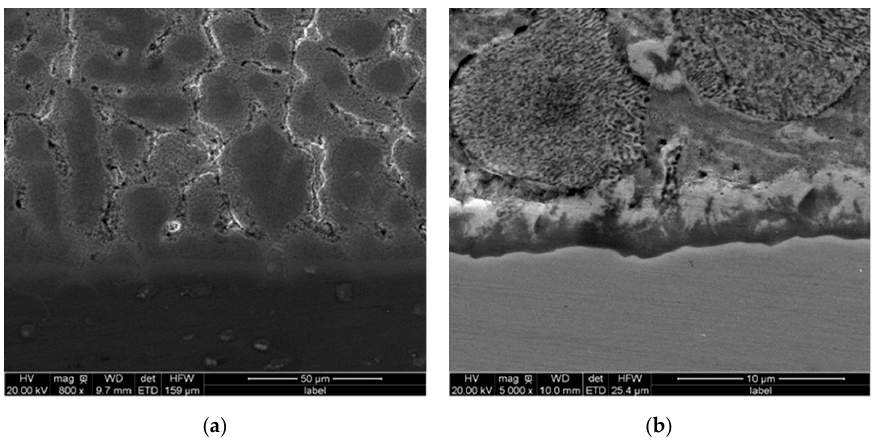
Figure 5. Microstructure at the interface of the joint: ( a ) 5052 aluminum; ( b ) Q235 low-carbon steel.